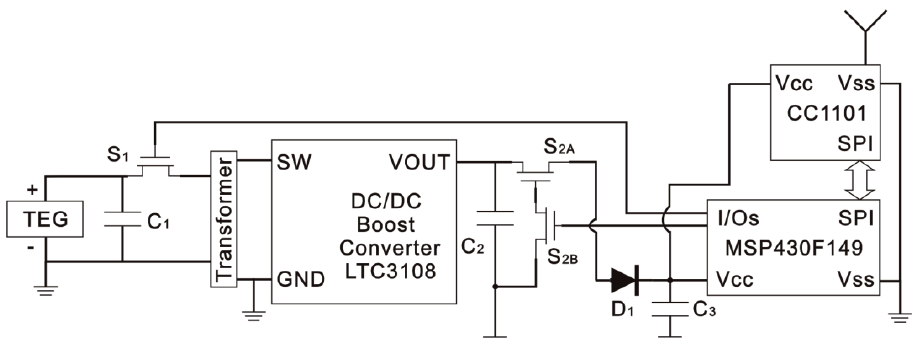
Figure 8. Circuit of power management